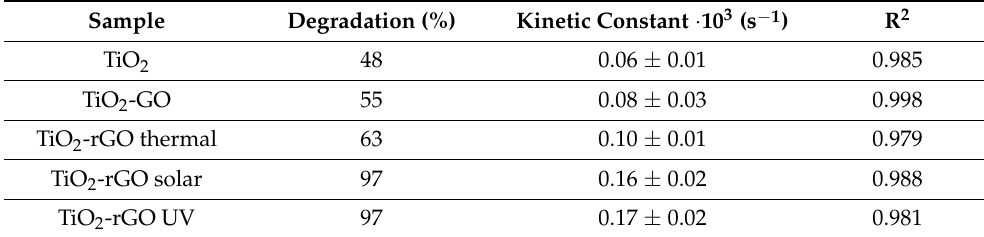
Table 3. Kinetic constants for 2,4-D